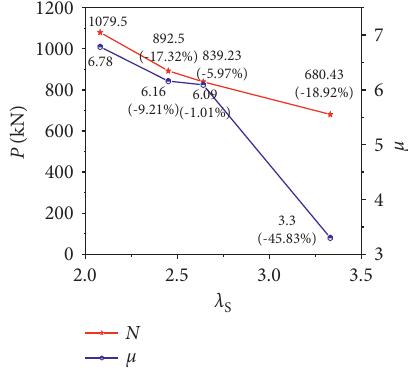
Figure 15: Relationships between Pu , μ , and λ